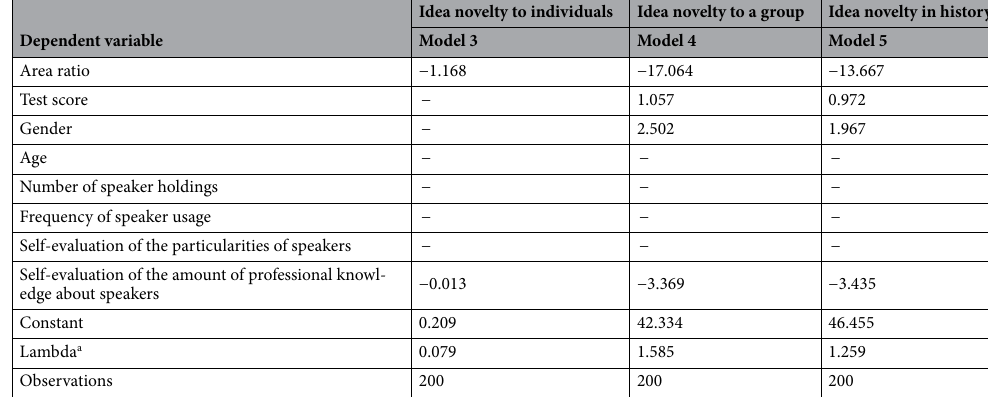
Table 3. Regression results for creative performance in the survey data. The − indicates that the variable was eliminated (i.e., had a coefficient of zero) in the LASSO regression. a The best lambda value is reported, which is estimated by the AIC of the models.